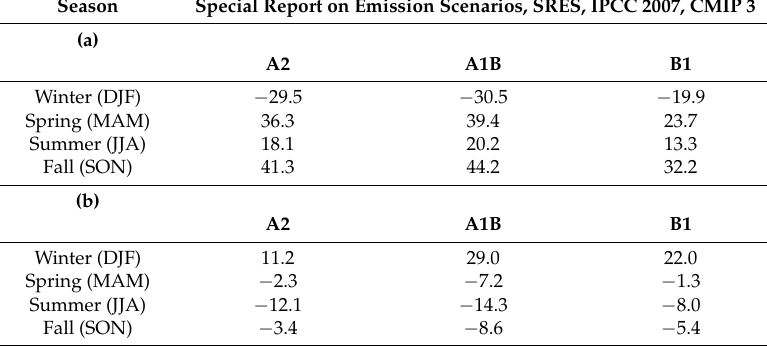
Table A2. Seasonal variations in projected climate change scenarios (based on the Special Report on Emission Scenarios, SRES, IPCC 2007, CMIP 3 † ) for the mid-21st century (2046–2065) in SKW, in percentage with respect to the baseline (1987–2000): ( a ) Temperature; ( b )